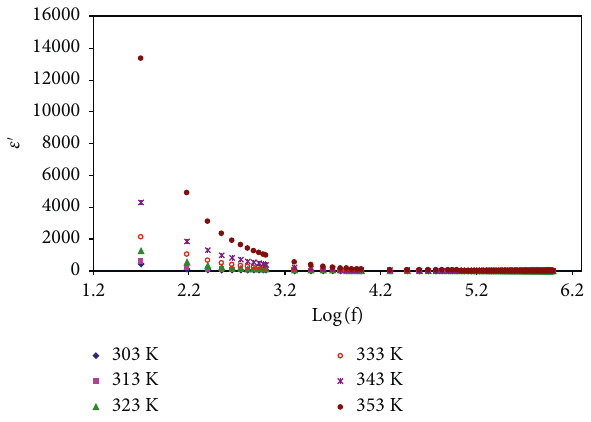
Figure 6: Dielectric constant versus frequency at various tem- peratures for the PBS1 blend sample.